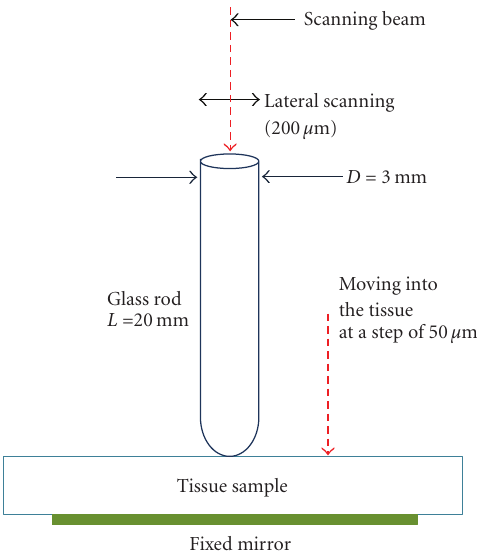
Figure 2: Experimental setup for tissue